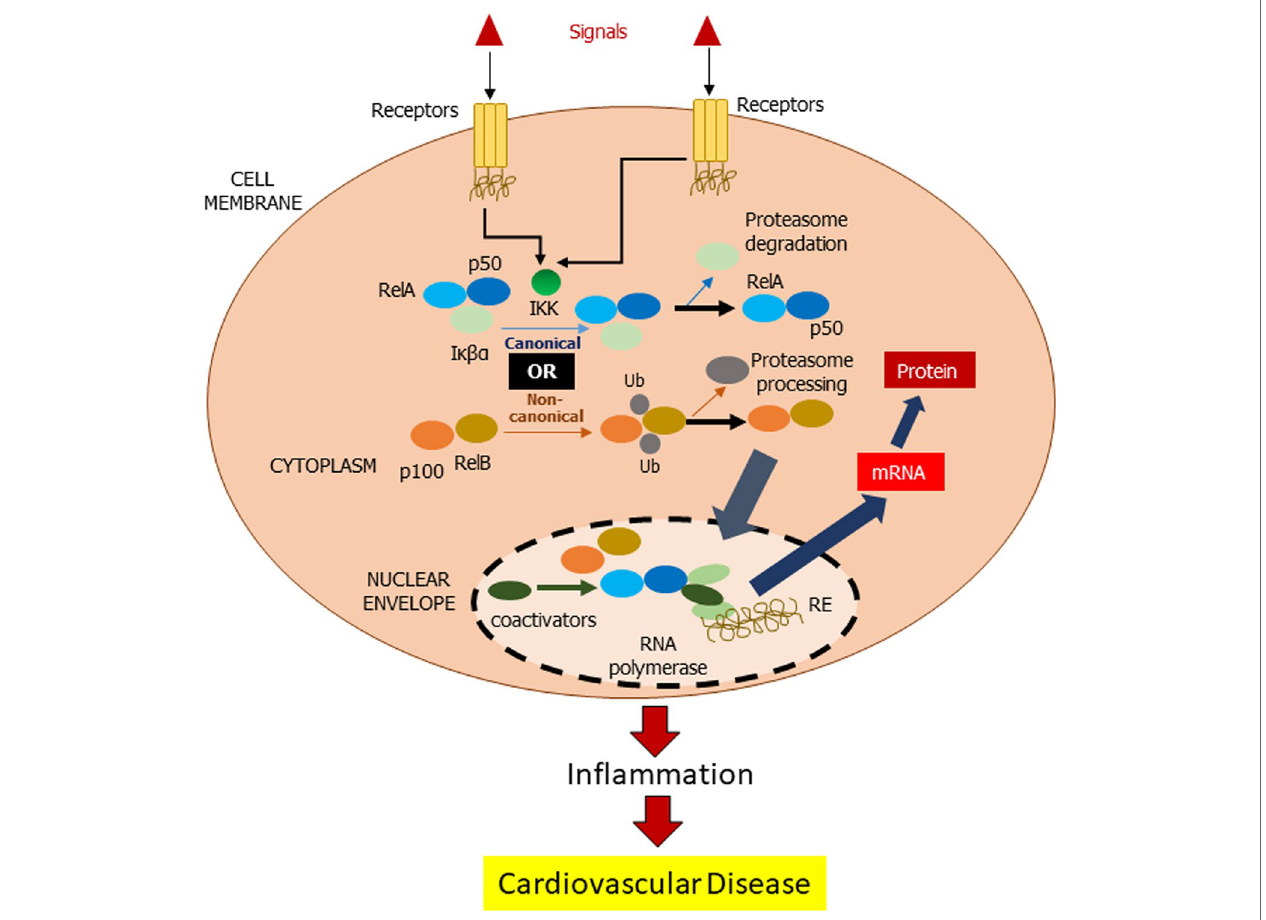
FIGURe 1 | Mechanism of NFκB action. In inactivated state, NF-κβ, which consists of Rel and p50 proteins, is located in the cytosol complexed with the inhibitory protein Iκβα. IκB kinase (IKK) is activated by extracellular signals via membrane receptors. Subsequently, IKK phosphorylates the Iκβα protein resulting in ubiquitination of Iκβα and eventually by the proteasome for Iκβα degradation (canonical pathway). In non-canonical pathway, RelB favors the activation of NF-κβ via RelB. Activated NF-κβ is further translocated into the nucleus for DNA bindings, called response elements (RE). The DNA/NF-κβ complex attracts coactivators and RNA polymerase, which transcribe the DNA into mRNA resulting in a cell